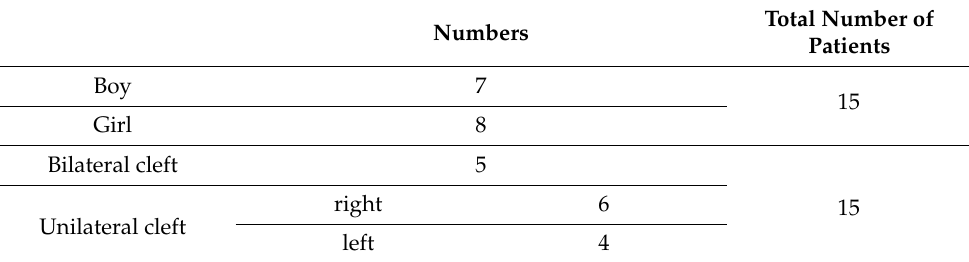
Table 1. Patient Characteristics and Classification.